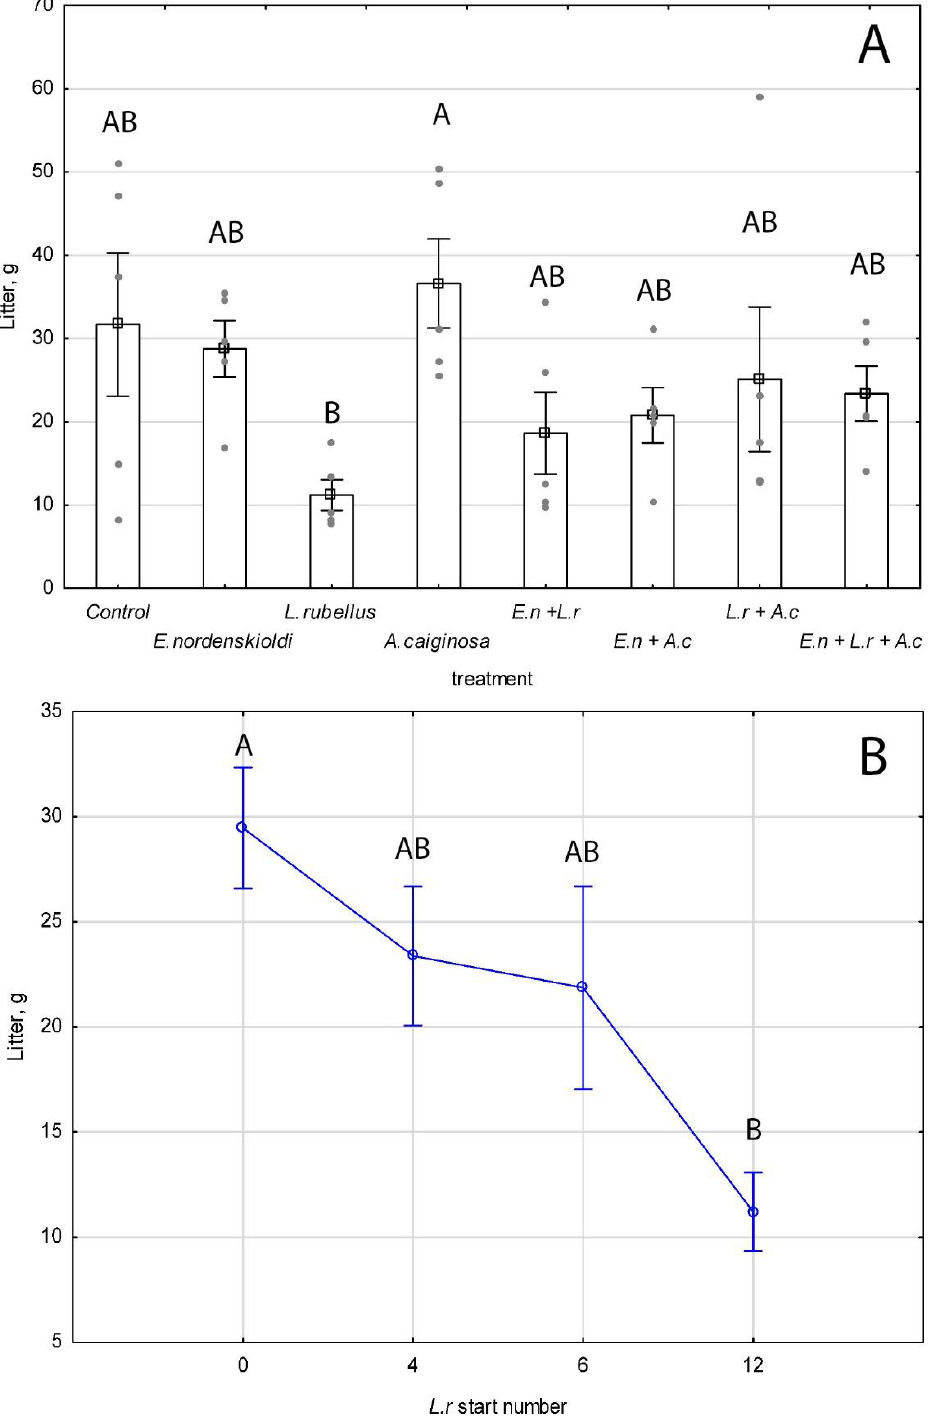
Figure 4. Amount of litter at the end of the vegetation experiment ( A ) in the variants of experiments, mean ± error of mean, raw data. ( B ) depending on the initial number of L. rubellus. Variants with different letters show significant differences ( α = 0.05 Tukey